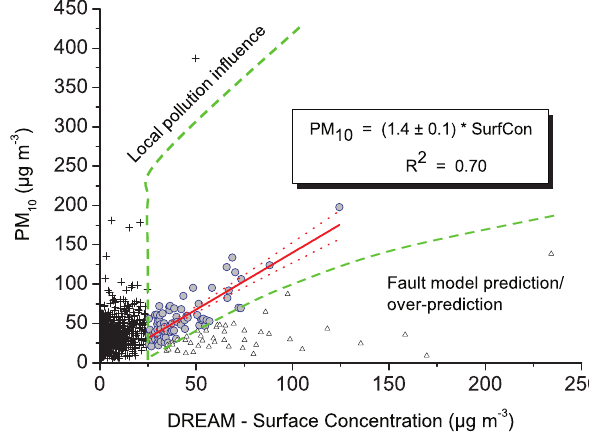
Fig. 6. PM 10 measured at a ground station in Athens versus the sur- face concentration of dust particles derived from the BSC-DREAM model. Crosses and triangles are cases of high local pollution in- fluence and are not confirmed by observations or model predicted dust events, respectively. Circles correspond to the cases taken into account for the regression